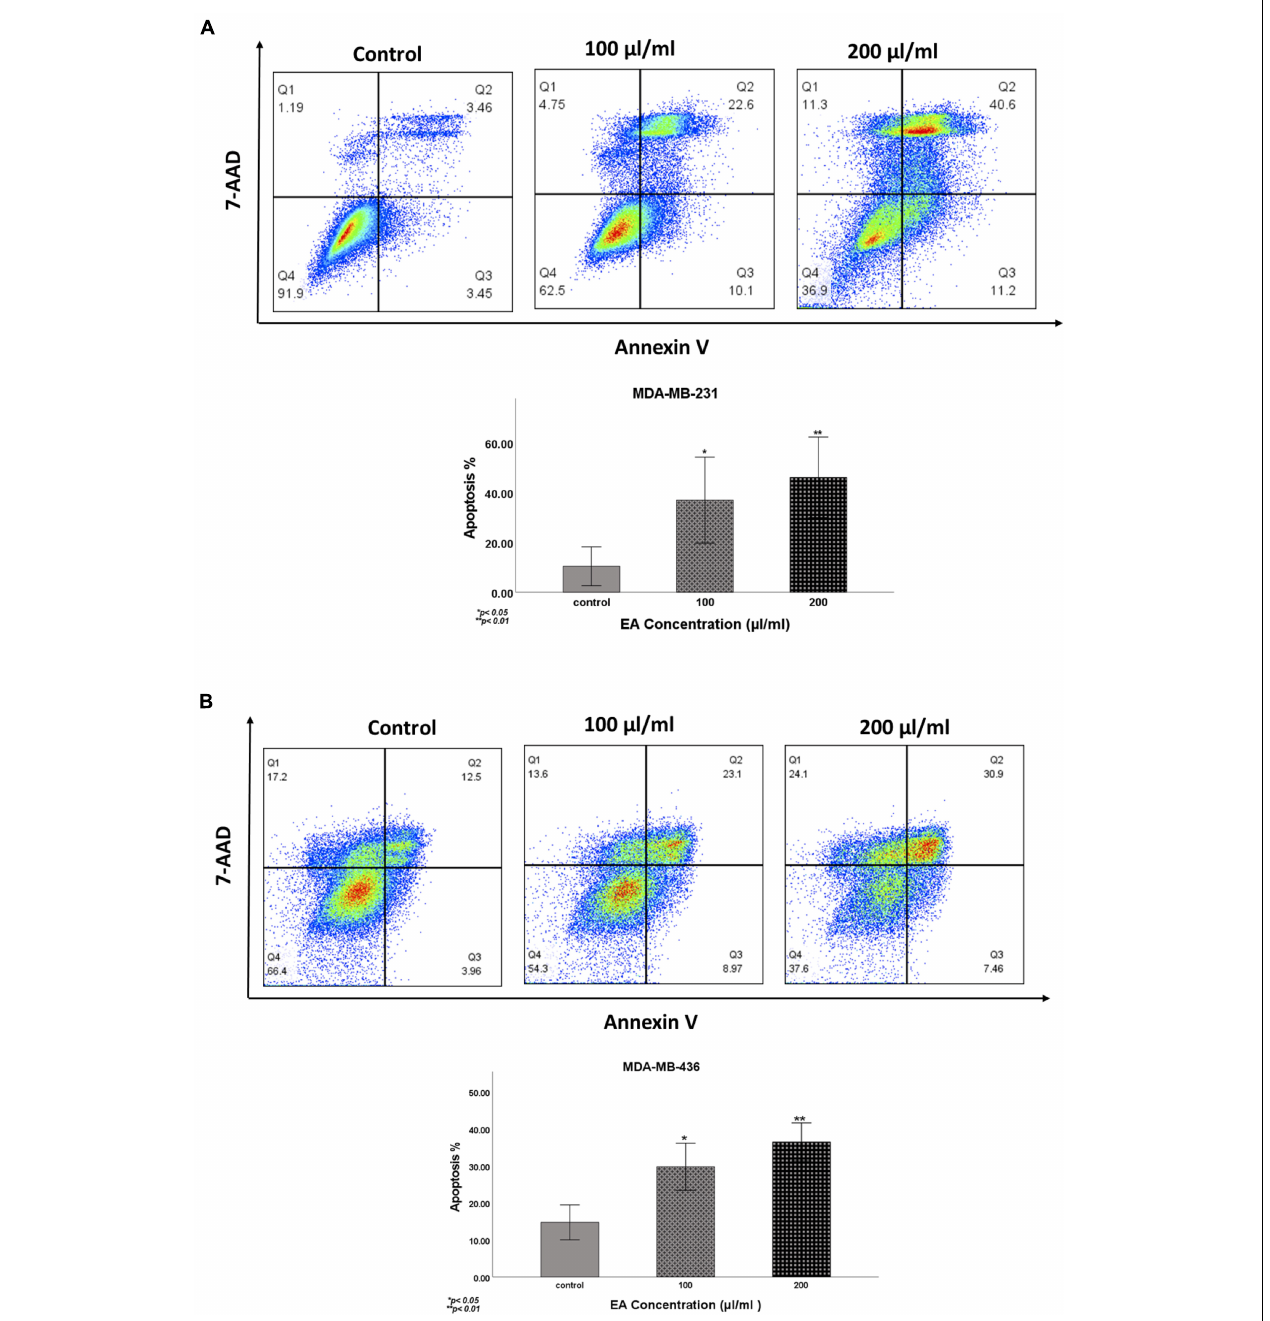
FIGURE 4 | Induction of apoptosis by EA extract in (A) MDA-MB-231 and (B) MDA-MB-436 cells, as determined by Annexin V-FITC and 7-AAD apoptosis assay. Cells were treated with 100 and 200 µ l/ml of EA extract for 48 h. Data are presented as Mean ± SEM ( N = 3). Results were analyzed using One-way ANOVA followed by Dunnett’s post hoc test. p < 0.05 was considered for statistical significance. * p < 0.05 and ** p < 0.01.